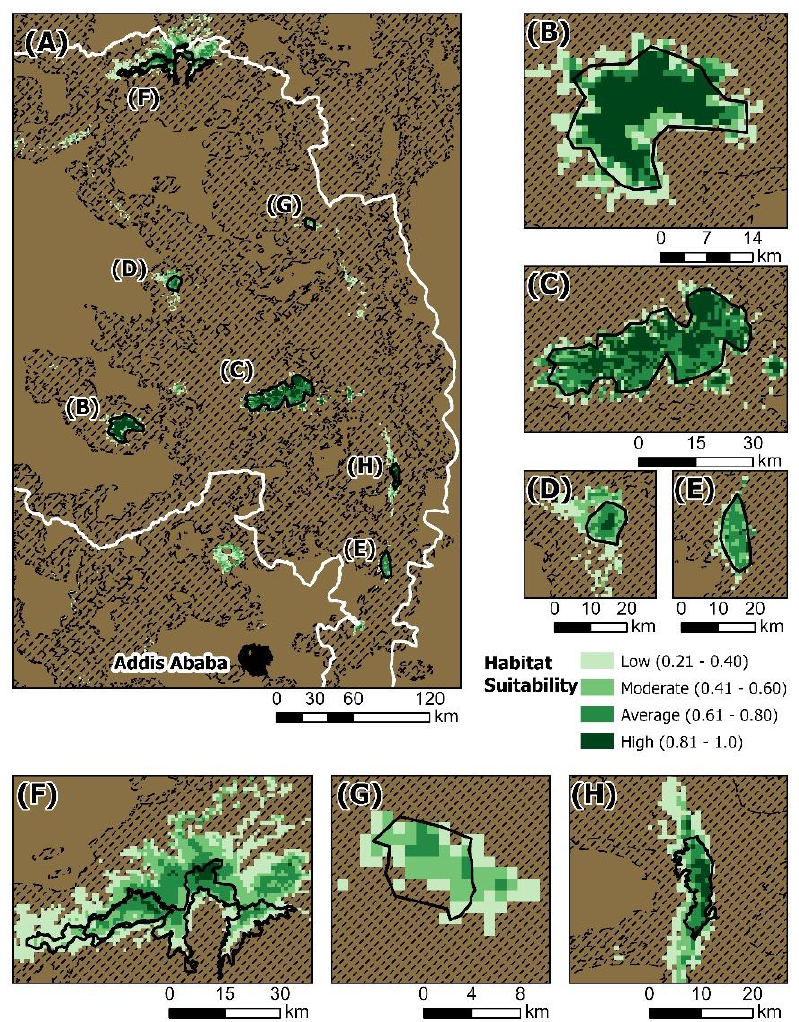
Figure 3. Map of predicted guassa grass habitat suitability, showing the distribution of habitat ( A ) throughout the state of Amhara (outlined in white), ( B ) on Mount Choke, ( C ) in South Wollo, ( D ) on Mount Guna, ( E ) around Ankober, ( F ) in and around Simien Mountains National Park, ( G ) in and around Abune Yosef Community Conservation Area, and ( H ) in and around Guassa Community Conservation Area. Boundaries for ( B – E ) indicate potential protected areas, while ( F – H ) represent existing protected